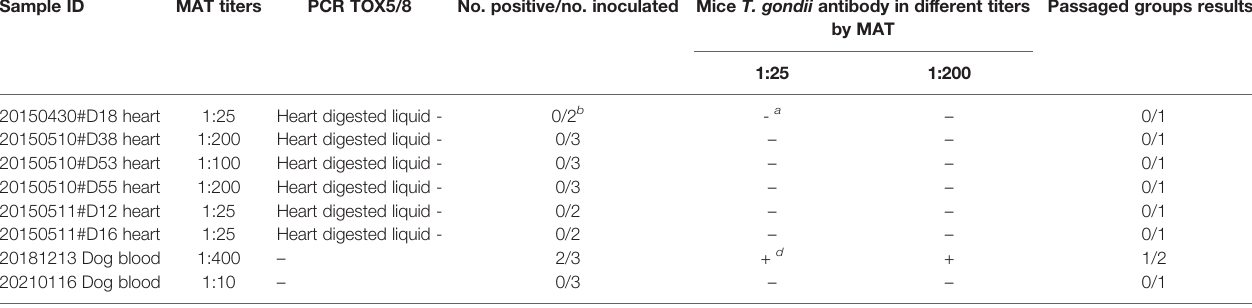
TABLE 4 | Isolation of T. gondii from dogs by bioassay in mice. Sample ID MAT titers PCR